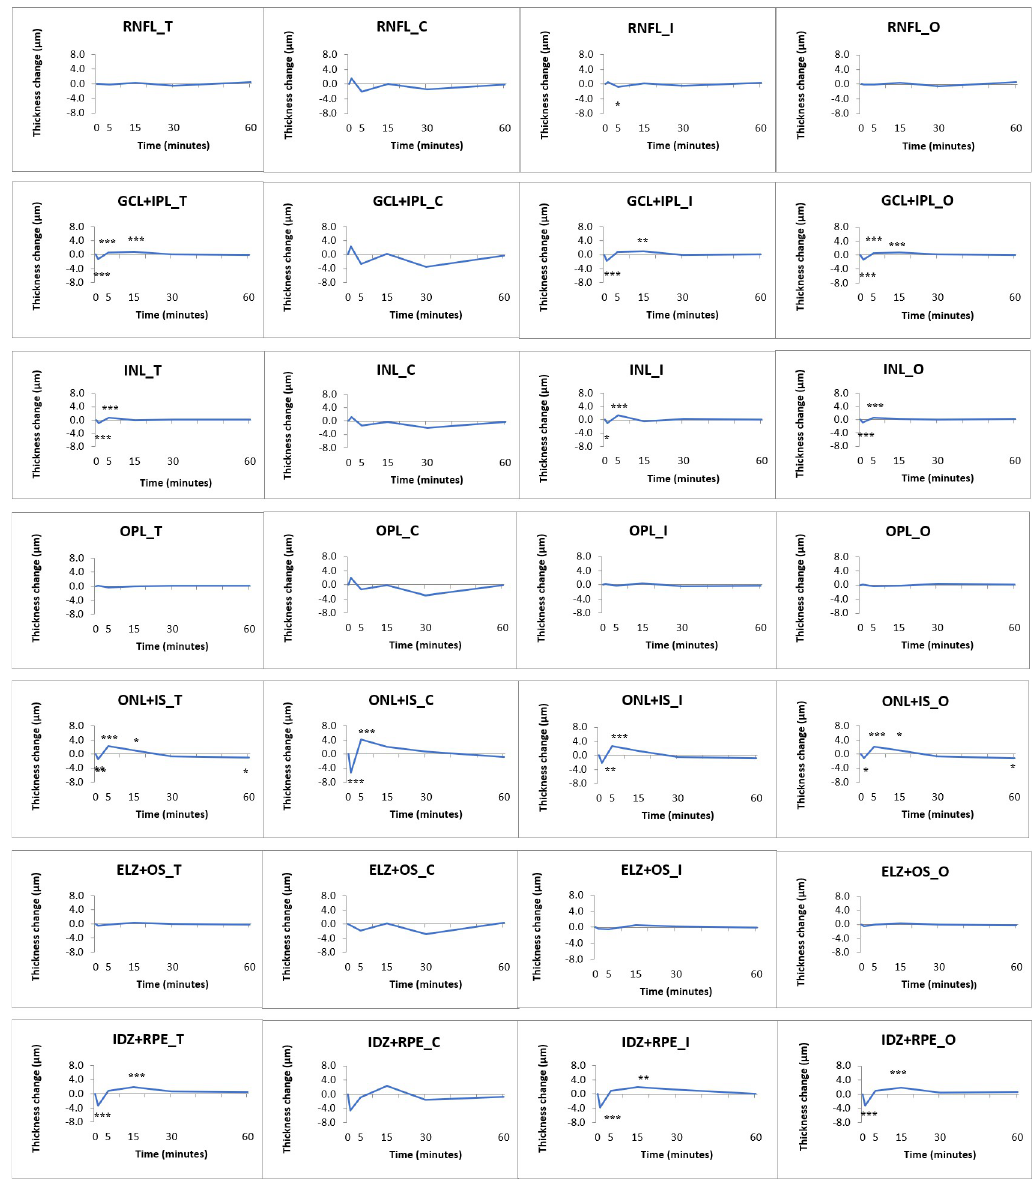
Fig 5. Changes of single retinal layer thickness over time following vita maxima strain of the study participants. Data are shown in the total macular area (T), the central subfield (C), the inner (I) and outer ring (O). � : p < 0.05 (missed significance), �� : p < 0.01 (missed significance), ��� : p < 0.001 (significant). For mean and SD values see S4 Table. (For the abbreviations of the layers see Fig